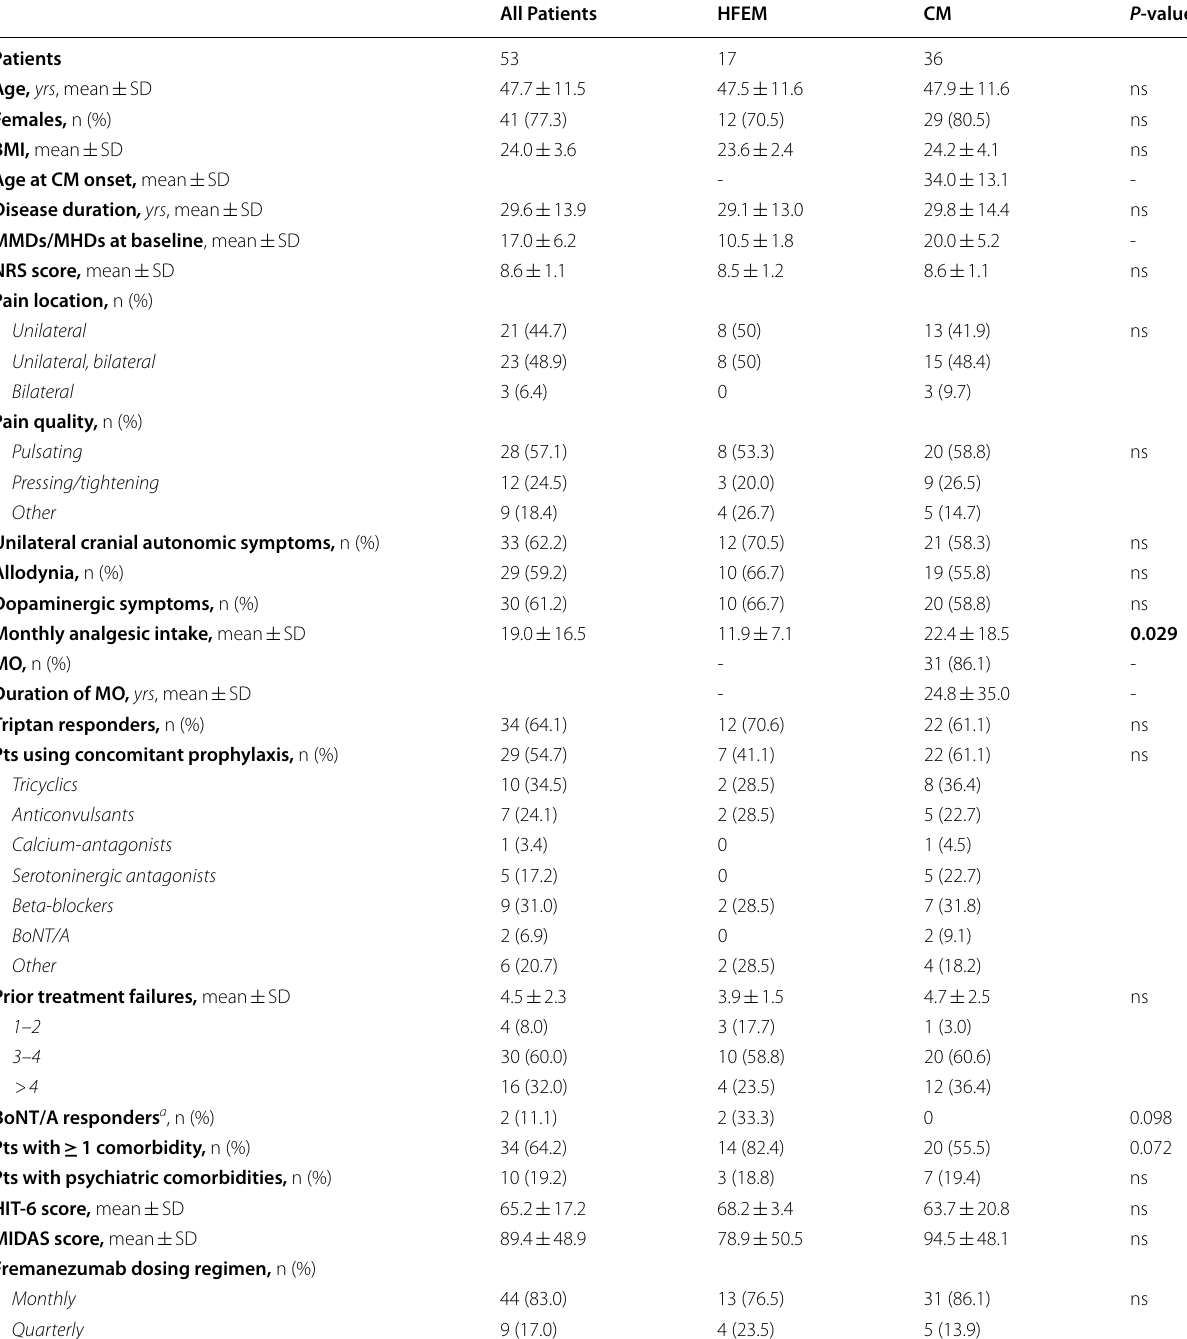
Table 1 Demographic and clinical features of patients with high-frequency episodic migraine (HFEM) or chronic migraine